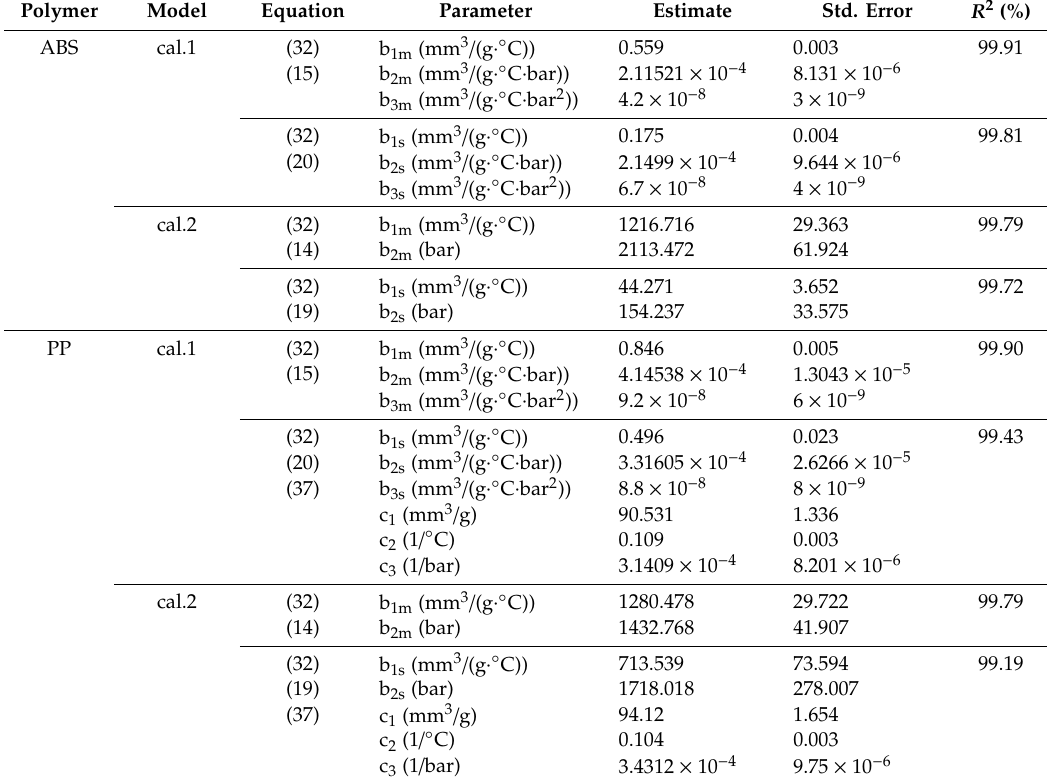
Figure 7. Comparison between the experimental pvT data and the calculated data by the discontinuous two-domain EoS for amorphous ABS ( a ) and semi-crystalline PP ( b ) and the continuous two-domain EoS for amorphous ABS ( c ) and semi-crystalline PP ( d ). Table 3. Parameters estimated by the continuous two-domain EoS considering the cooling rate.